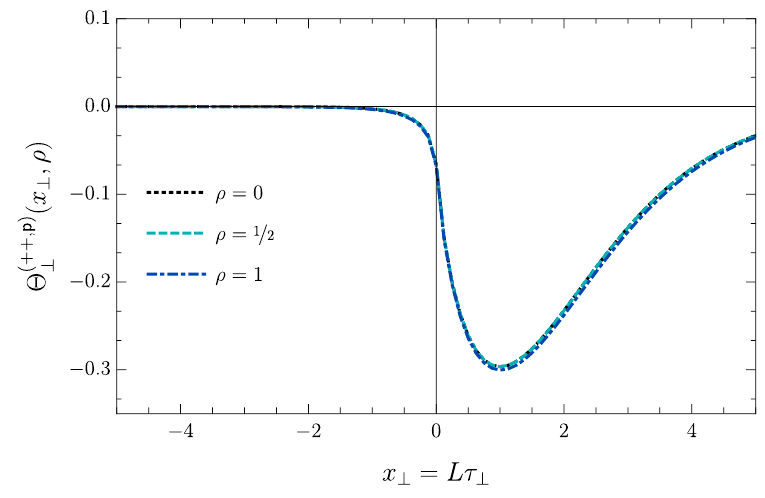
(++ , p ) ( x ρ ) of the free energy for different values of ⊥ , ⊥ (++) ( x ) ⊥ ⊥